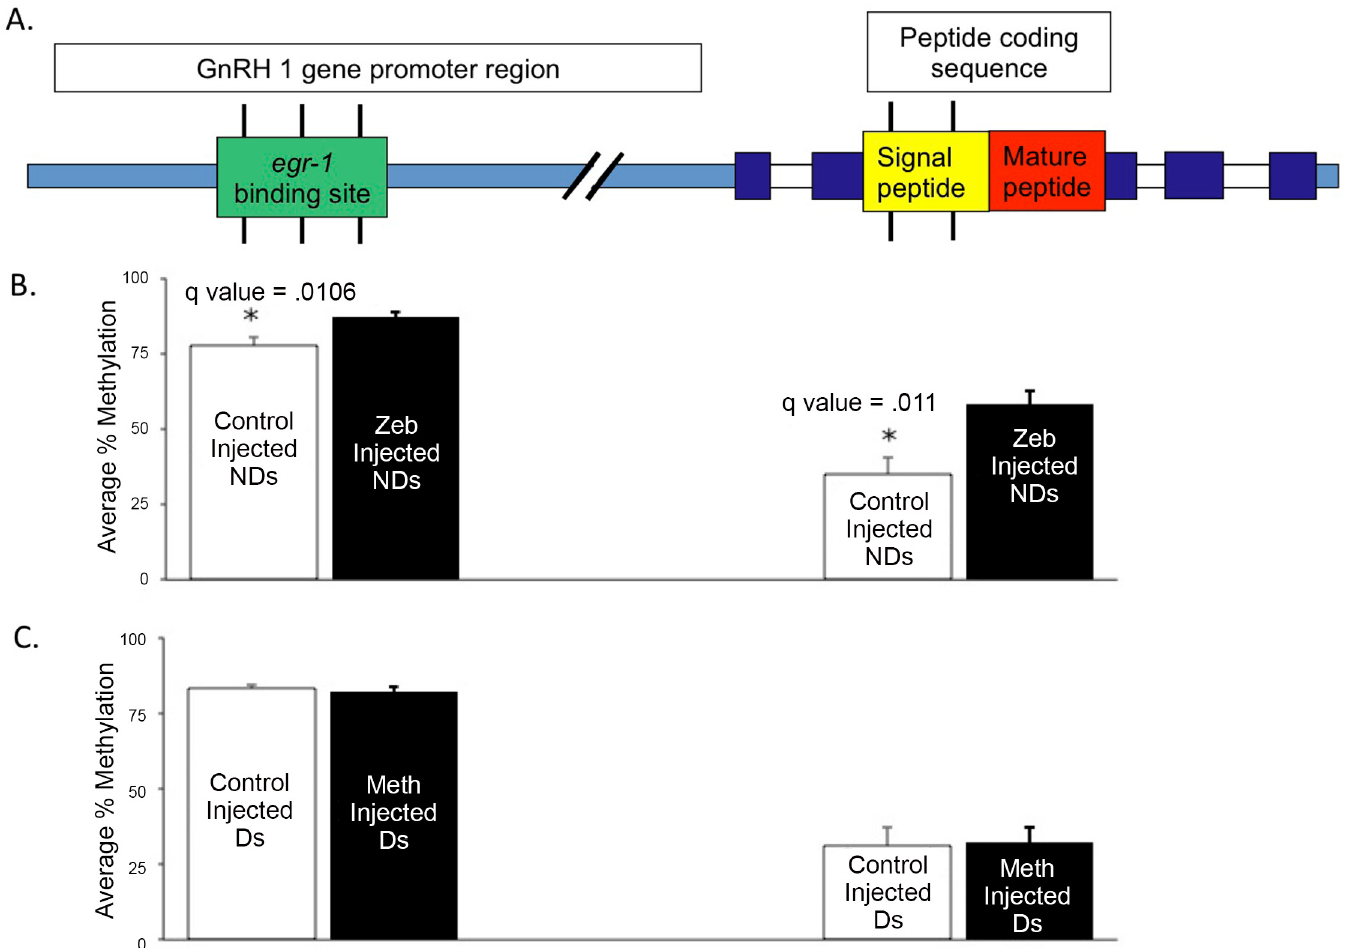
Fig 3. Differential methylation at CpG sites within functional genomic regions of GnRH1 in the pre-optic area (POA) in zebularine-injected, L- methionine-injected and control-injected dominant (D) and non-dominant (ND) males 5 days after initial injection. A . Methylation was assayed in two locations on the GnRH1 gene; in the promoter region within the binding site of egr1 (3 CpG sites indicated by single vertical bars within the green rectangle) and in the coding region in the sequence of the signal peptide (2 CpG sites indicated by single bars within the yellow rectangle). B . Average methylation levels in GnRH1 genomic regions of zebularine-injected ND males that show significantly higher average methylation levels than control-injected ND males in the egr-1 binding site located in promoter region of GnRH1 . ( * q-value < 0.05; n = 3 – 4 per group). C . Average methylation levels in GnRH1 genomic regions of methionine-injected ND males are not significantly different from those of control injected animals (q-value > 0.05 for all groups; n = 3 – 8 per group). Statistical significance for each of these regions was calculated by determining combined Fisher ’ s p values and then calculating q values estimating the multiple-testing-corrected false discovery rate (see Methods in S1 File for complete description). Error bars represent